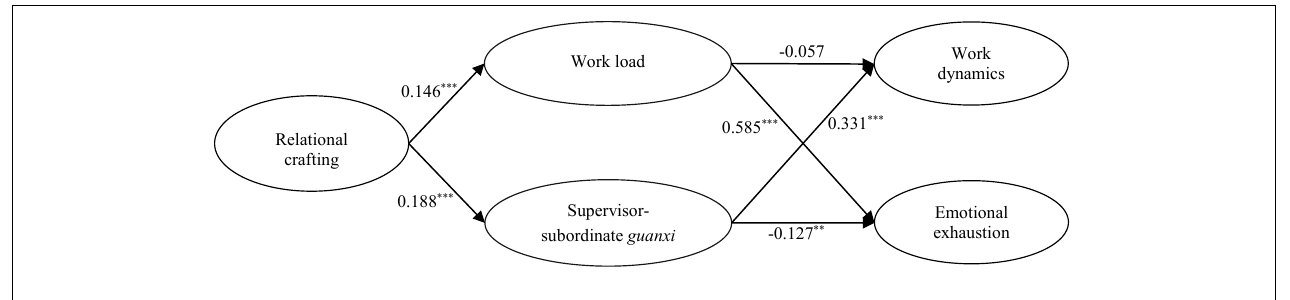
FIGURE 2 | Path analysis results. *** p < 0.001, ** p < 0.01, and * p < 0.05.